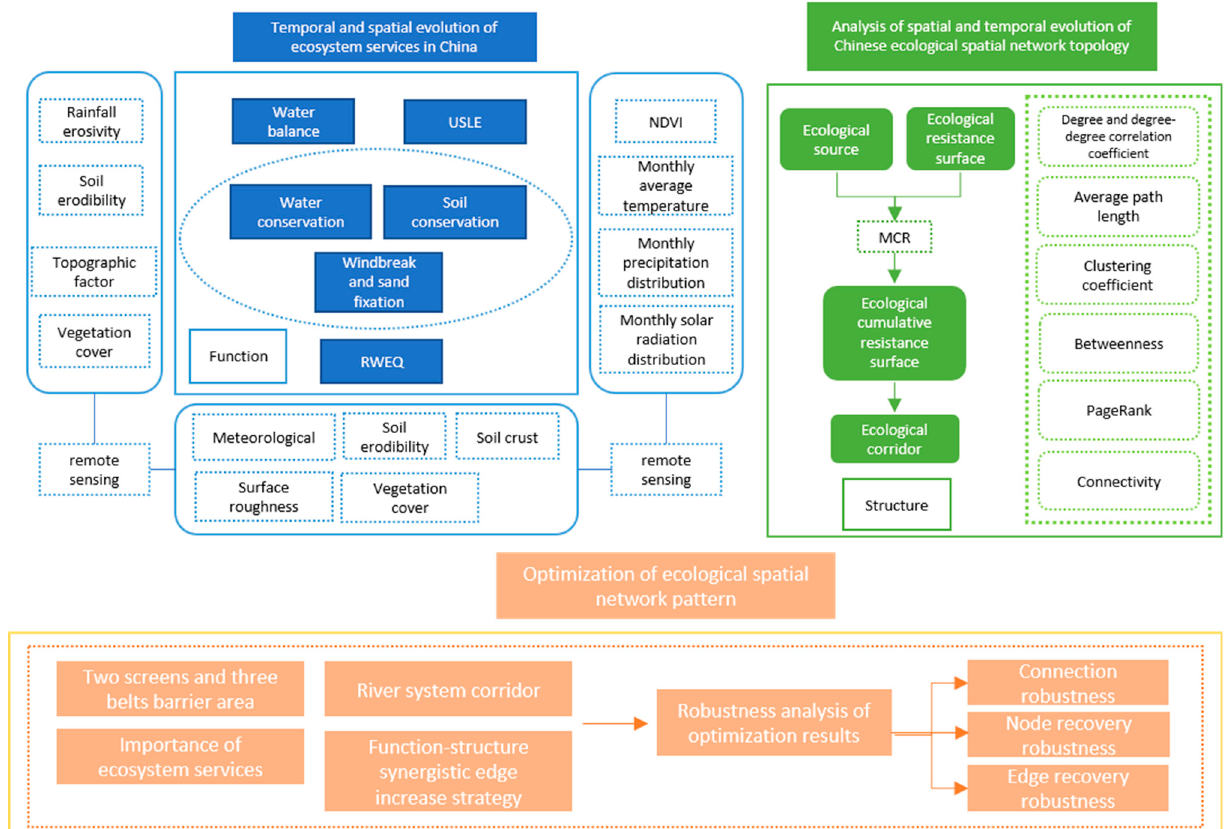
Figure 2. Technology roadmap.